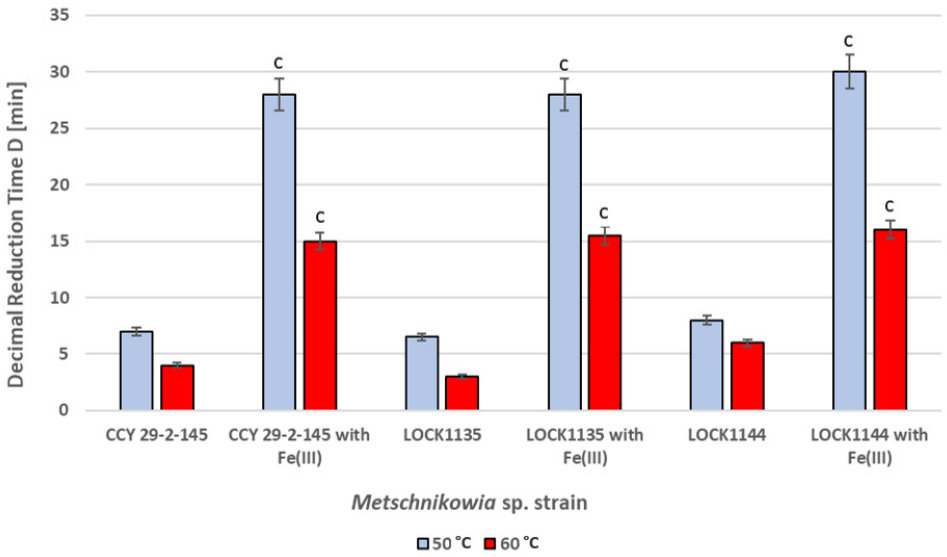
Figure 5. Decimal reduction times determined for three strains of M. pulcherrima clade: M. pulcherrima CCY 29-2-145, Metschnikowia sp. LOCK1135, and Metschnikowia sp. LOCK1144. Values show the mean ± standard deviation (SD, n = 3). Results obtained for minimal medium (control samples) were compared with those for minimal medium with Fe(III) ions (pulcherrimin production). Values with different letters are statistically different: c : p <